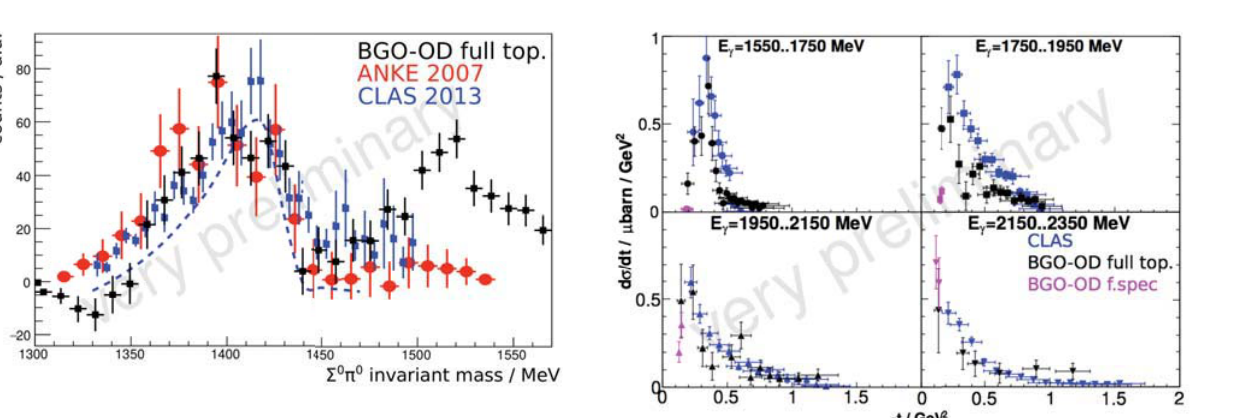
Figure 12. Λ (1405) → π 0 Σ 0 line shape (black points), compared to previous data from Zychor et al. [36] and Moriya et al. [37] the dashed line is the prediction of Nacher et al. [38] using a chiral unitary model where the Λ (1405) is dynamically generated via K − p interactions. Analysis by G. Scheluchin [28].